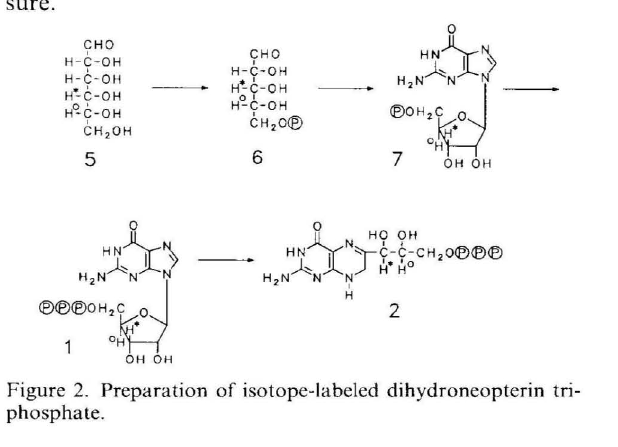
Figure 2. Preparation of isotope-labeled dihydroneopterin tri phosphate.